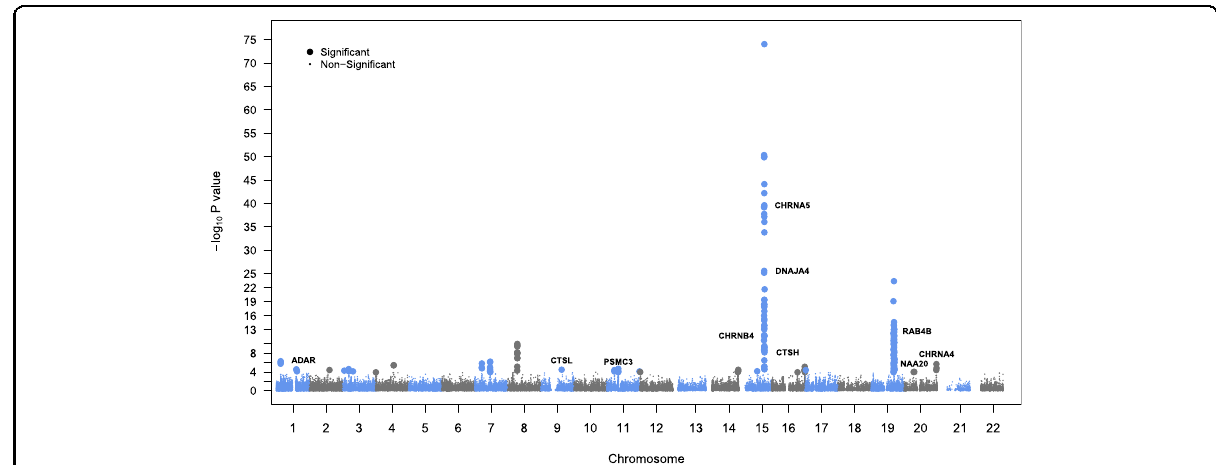
Fig. 2 Plot of gene-based test results. Manhattan plot shows results of all three gene-based tests: MAGMA, H-MAGMA (neuron and astrocyte cell types; fetal and adult brain tissues), and S-MultiXcan (13 GTEx brain tissues) for human cigarettes per day. The labeled genes are those identi fi ed from our nicotine gene list derived from model organisms.